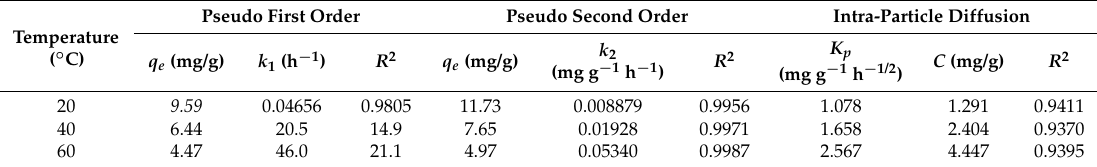
Table 4. Kinetic parameters for adsorption of HCHO on